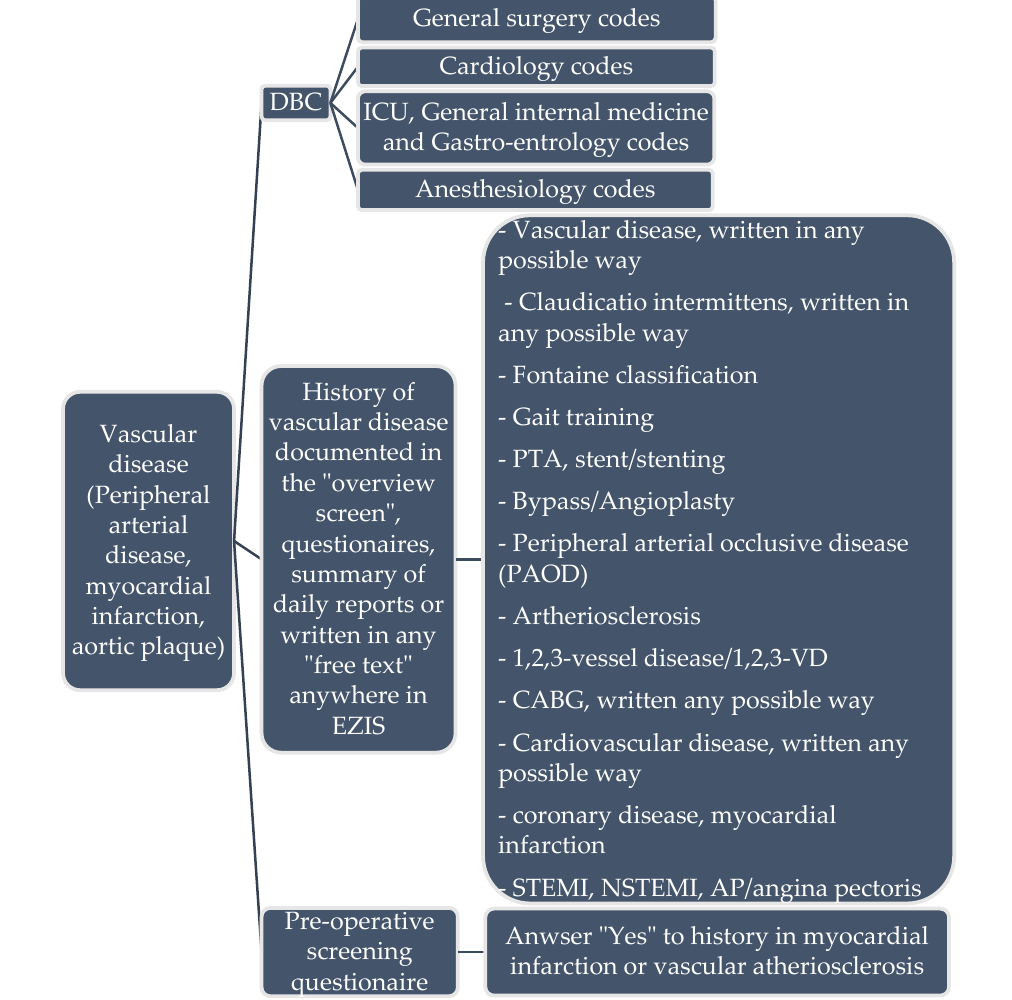
Figure 2. Example of information input to Gaston for extracting data from EZIS. DBC: Diagnose treatment combination (code for the healthcare insurance in the Netherlands to determine healthcare costs). PTA: percutaneous transluminal angioplasty.